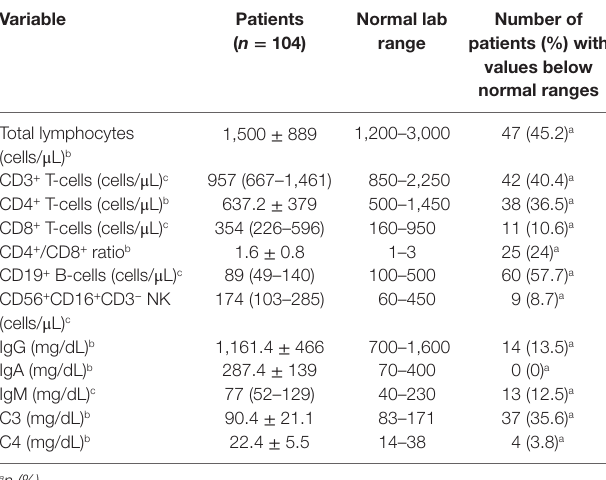
TaBle 2 | Lymphocyte populations, immunoglobulins, and complement results. Variable